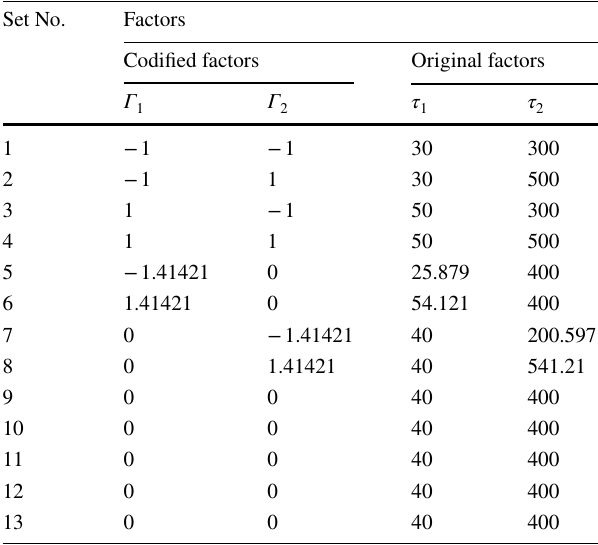
Table 2 Experimental central composite design matrix of Synozol dye oxidation Set No.